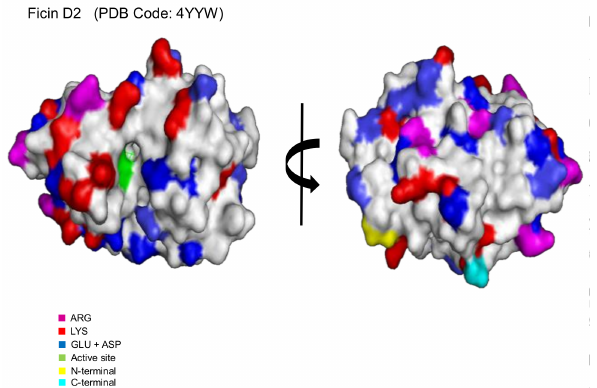
Figure 5. 3D surface structure model of Ficin D 2 obtained from the PDB and displayed using PyMol versus 0.99. Arg, Lys, Glu+Asp, -NH 2 terminal and -COOH terminal residues are